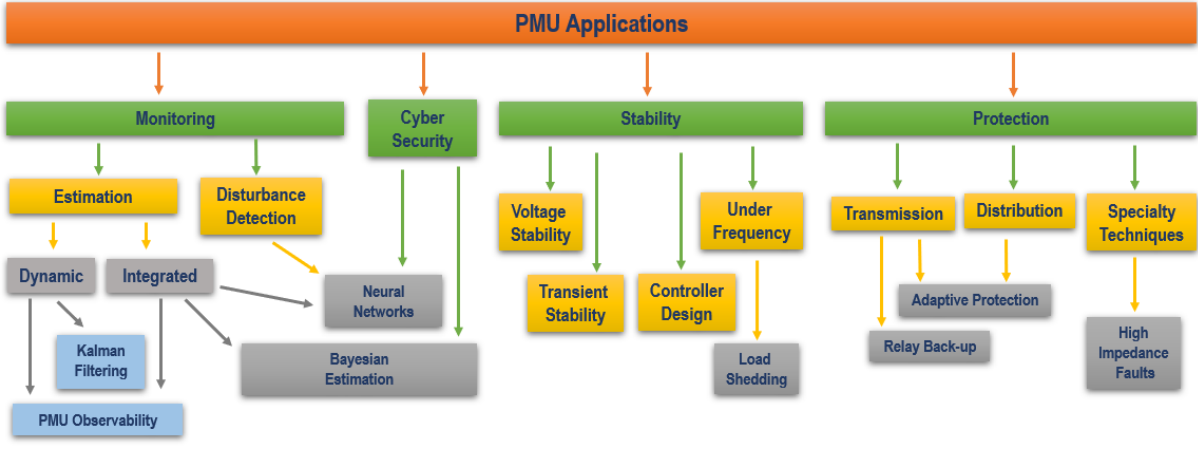
Figure 1. PMU application areas covered in this